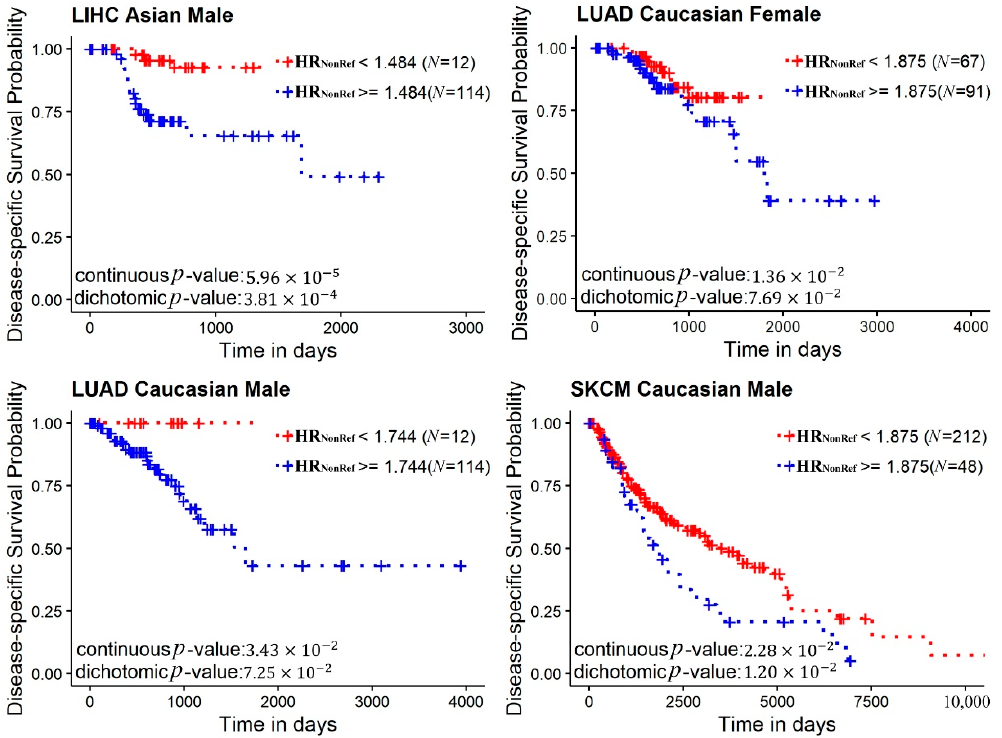
Figure 5. Disease-specific survival analysis results presented in Kaplan–Meier plots. R’ maxstat package was used to identify the optimal point for dichotomization. Two p -values are presented in the figure, one from Cox proportional hazards regression models without dichotomizing the data, and one from Cox proportional hazards regression models with dichotomized data.